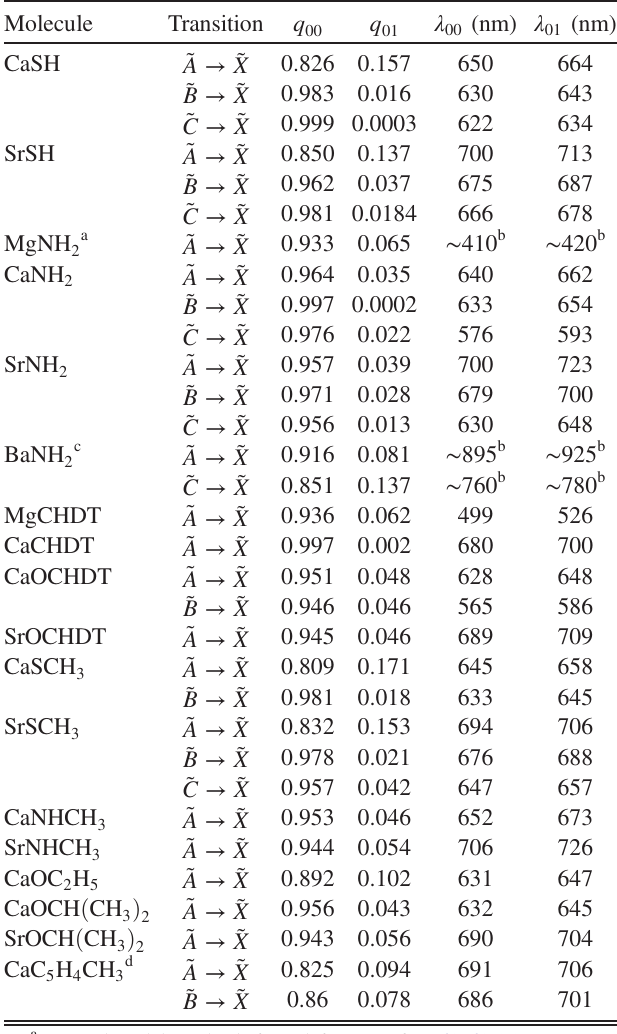
TABLE III. Franck-Condon factors calculated for decay to 0 quanta ( q 00 ) and 1 quantum ( q 01 ) of the metal-ligand stretching mode. Here, λ 00 and λ 01 are the main cycling and first repumping transition wavelengths in nm. Experimentally measured geom- etries and frequencies come from Refs. [52 – 66,68 – 71,73,74].